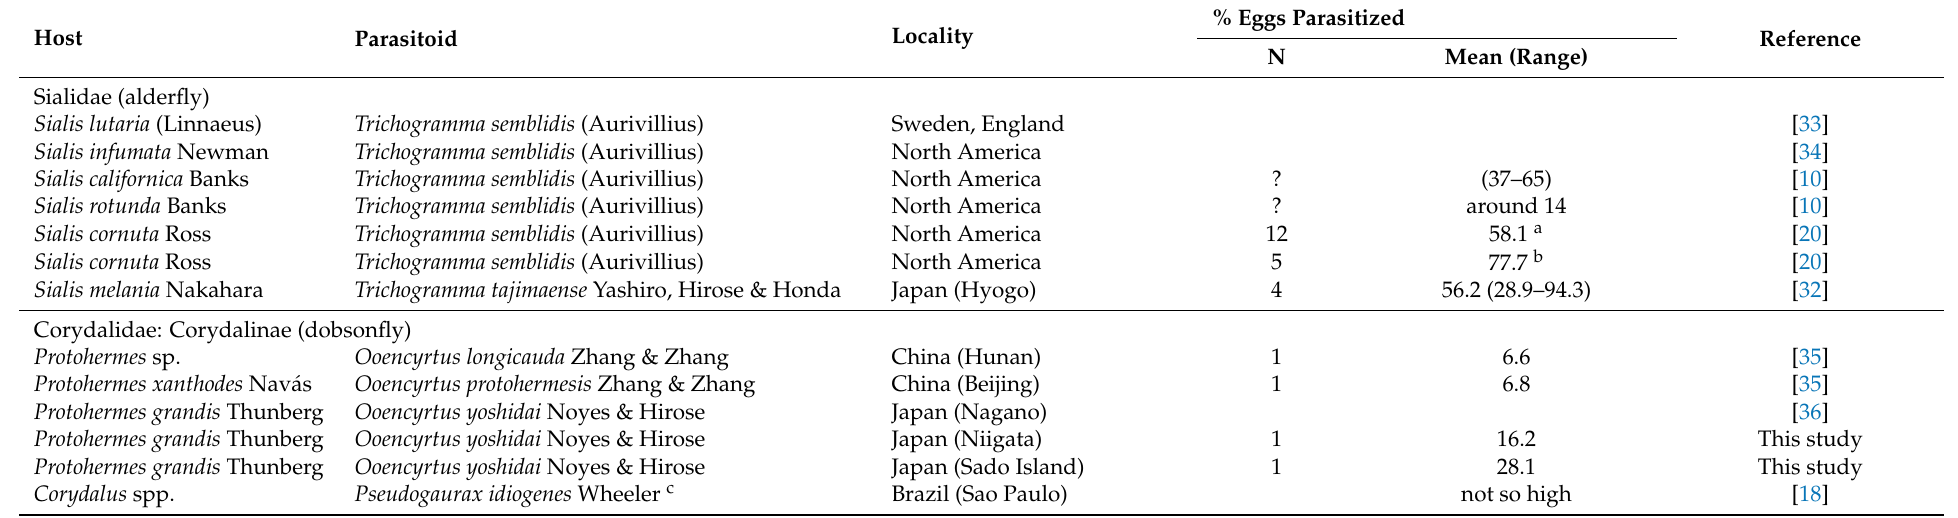
Table 3. Parasitoids known from Megaloptera egg masses: Trichogramma (Hymenoptera: Trichogrammatidae), Ooencyrtus (Hymenoptera: Encyrtidae) and Pseudogaurax (Diptera: Chloropidae). The percentages of parasitized eggs per parasitized egg mass are also shown (N is the number of parasitized egg masses